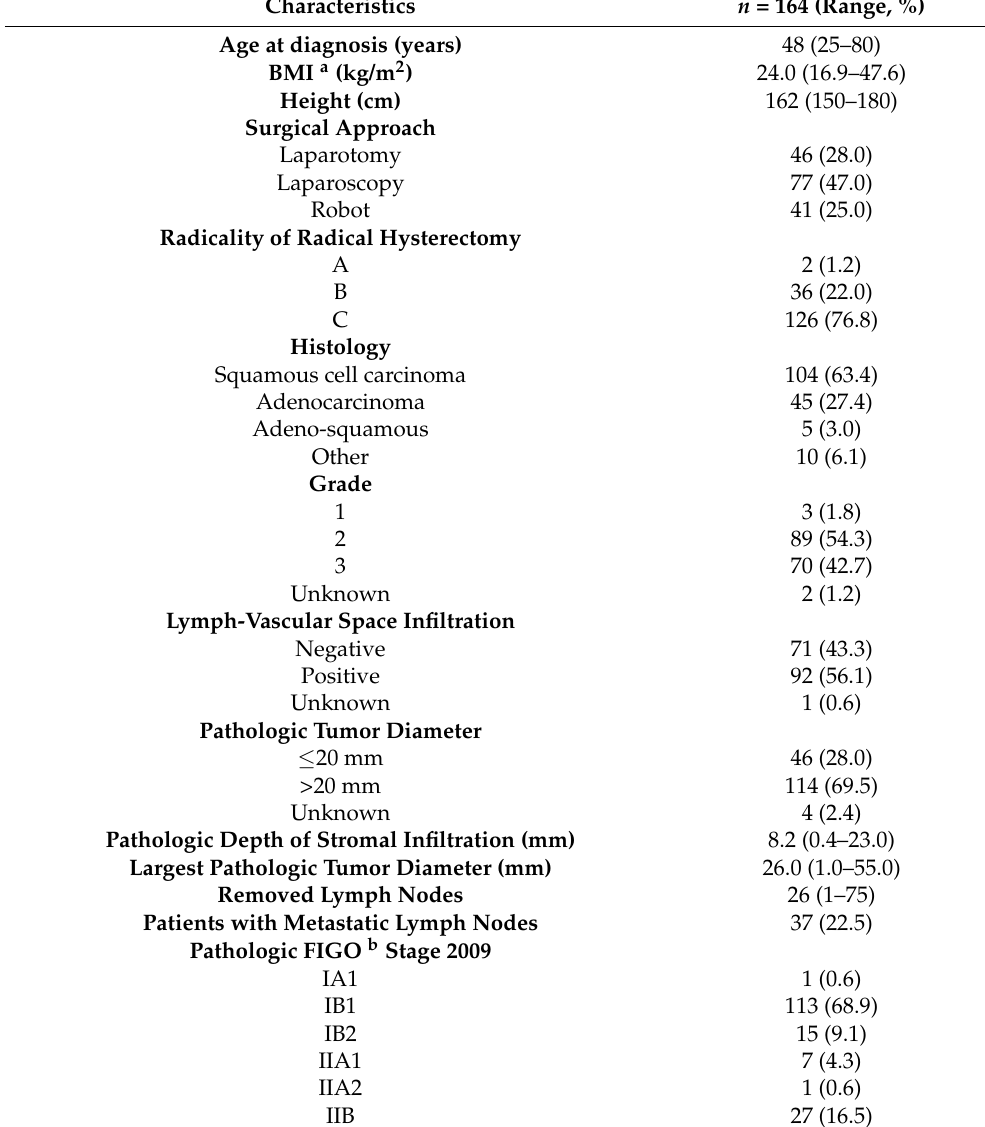
Table 1. Clinical, surgical, and histological characteristics of the study